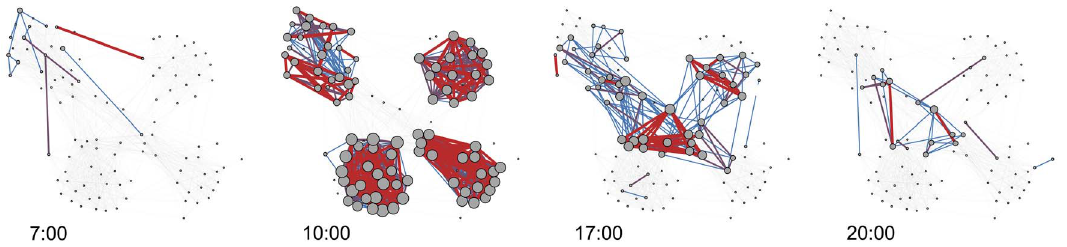
Figure 1. Dynamics of face-to-face interactions in the 2012 deployment. The participants meet in the morning, attend classes within four different study lines, and interact across majors in the evening. Edges are colored according to the frequency of observation, ranging from low (blue) to high (red). With 24 possible observations per hour, the color thresholds are respectively: blue ( 0 v observations ƒ 6 ), purple ( 6 v observations ƒ 12 ), and red ( v 12 observations). Node size is linearly scaled according to